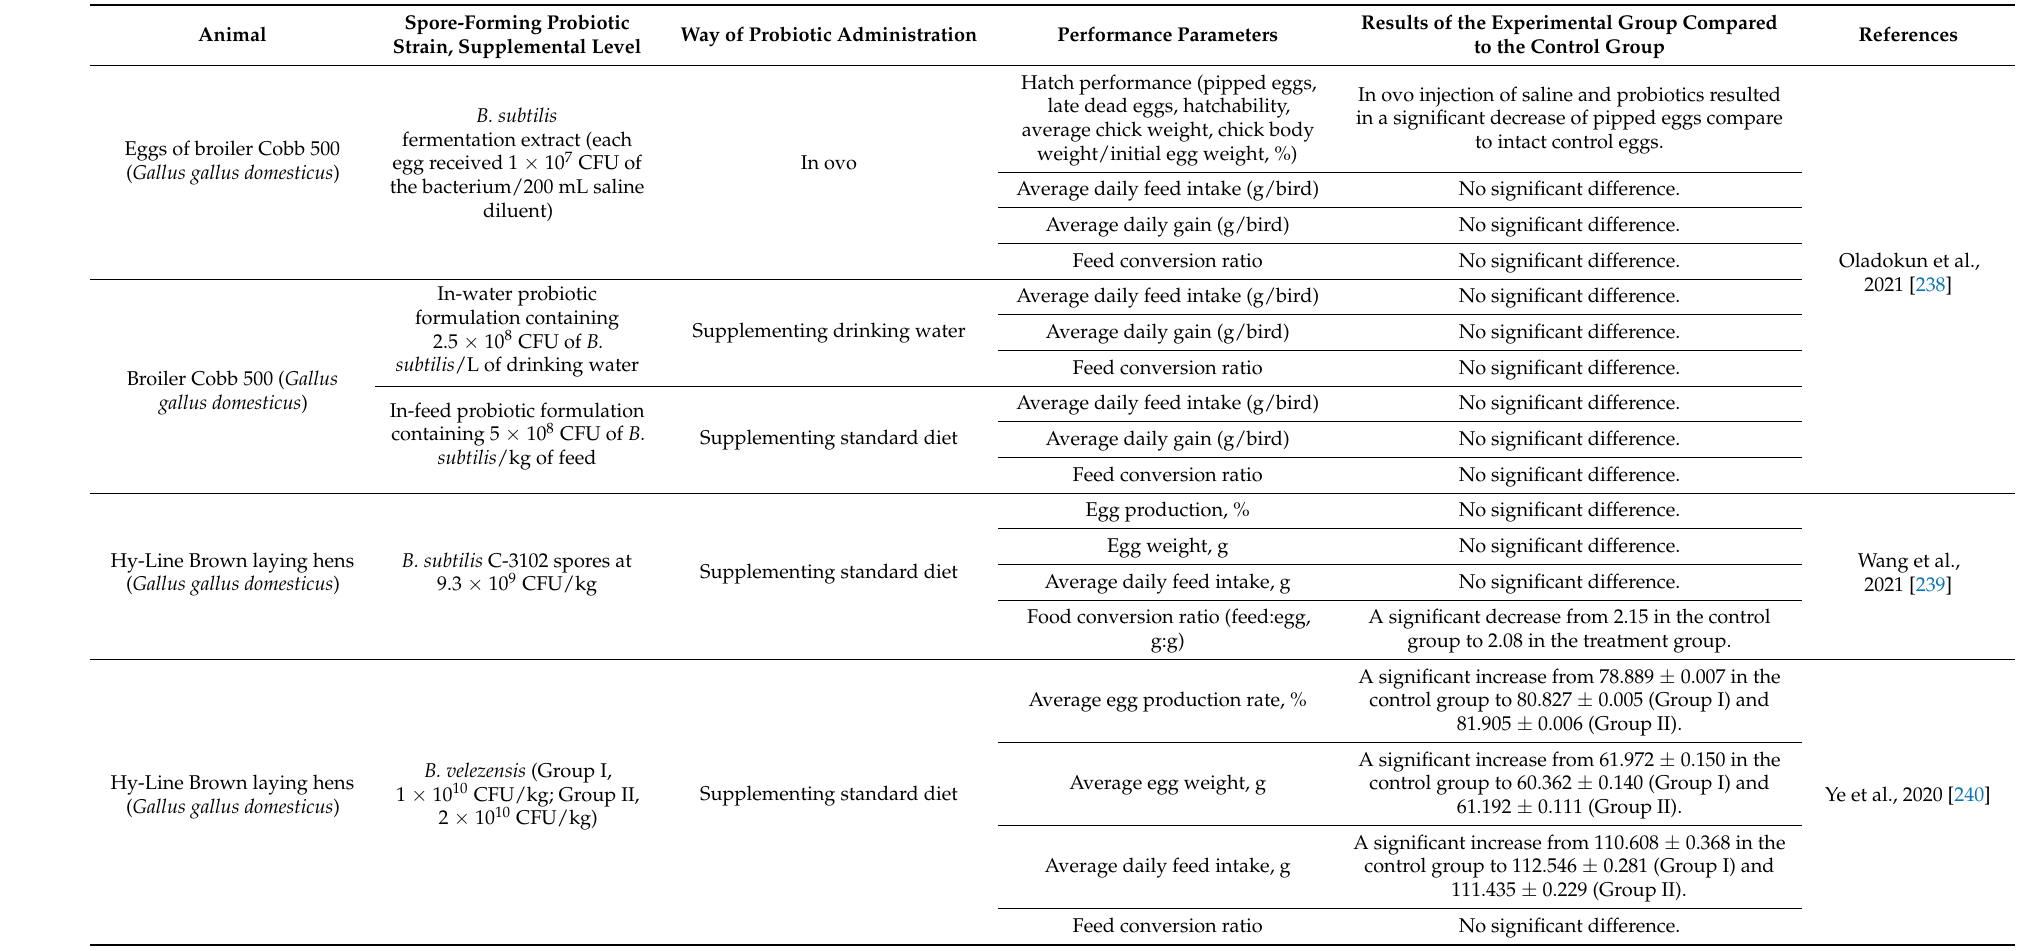
Table A1. Comparison table of studies of spore-forming probiotics effects on performance parameters in